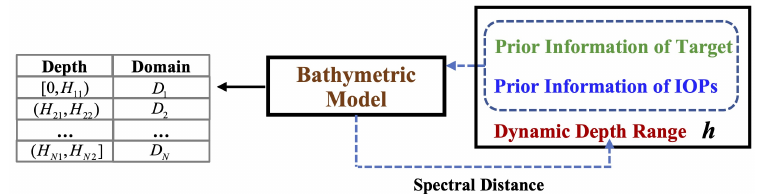
Figure 11. The synthetic dataset